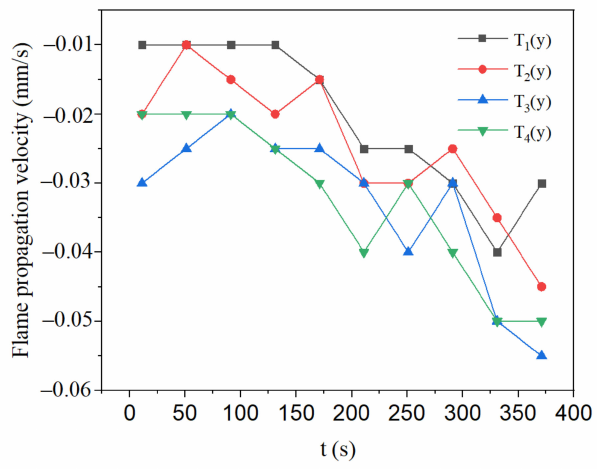
Figure 24. Variation of flame propagation velocity with time at different initial temperature peaks with the inlet flow rate of 700 m 3 /h, X CH